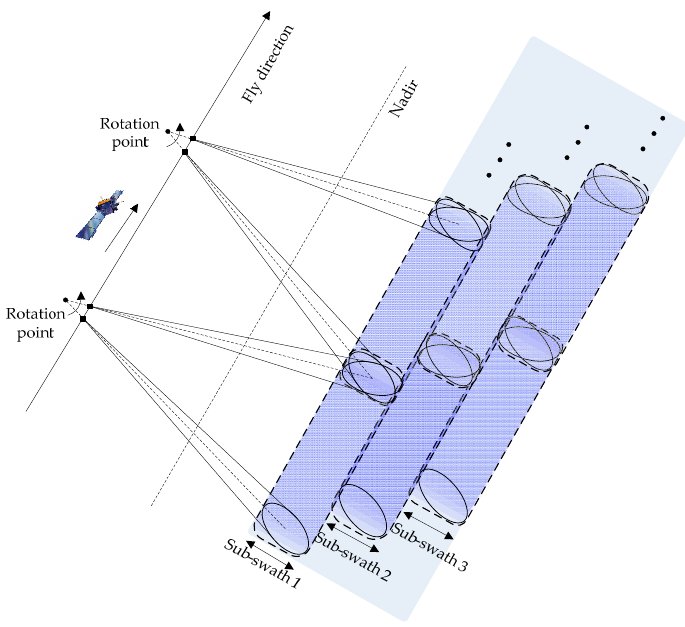
Figure 1 . Acquisition geometry of the spaceborne TOPS mode. Figure 1. Acquisition geometry of the spaceborne TOPS